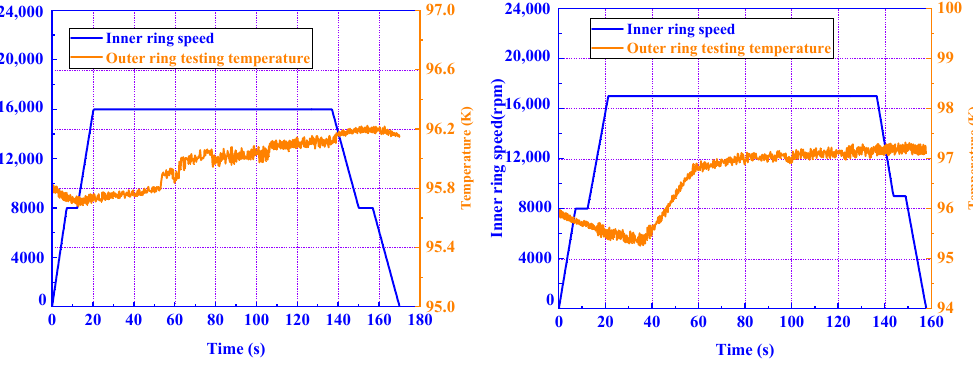
Figure 24. Temperature distribution.